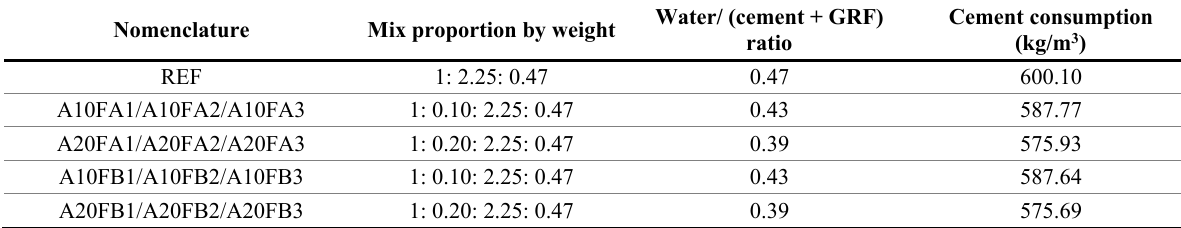
Table 3. Design parameters of the of the mortars